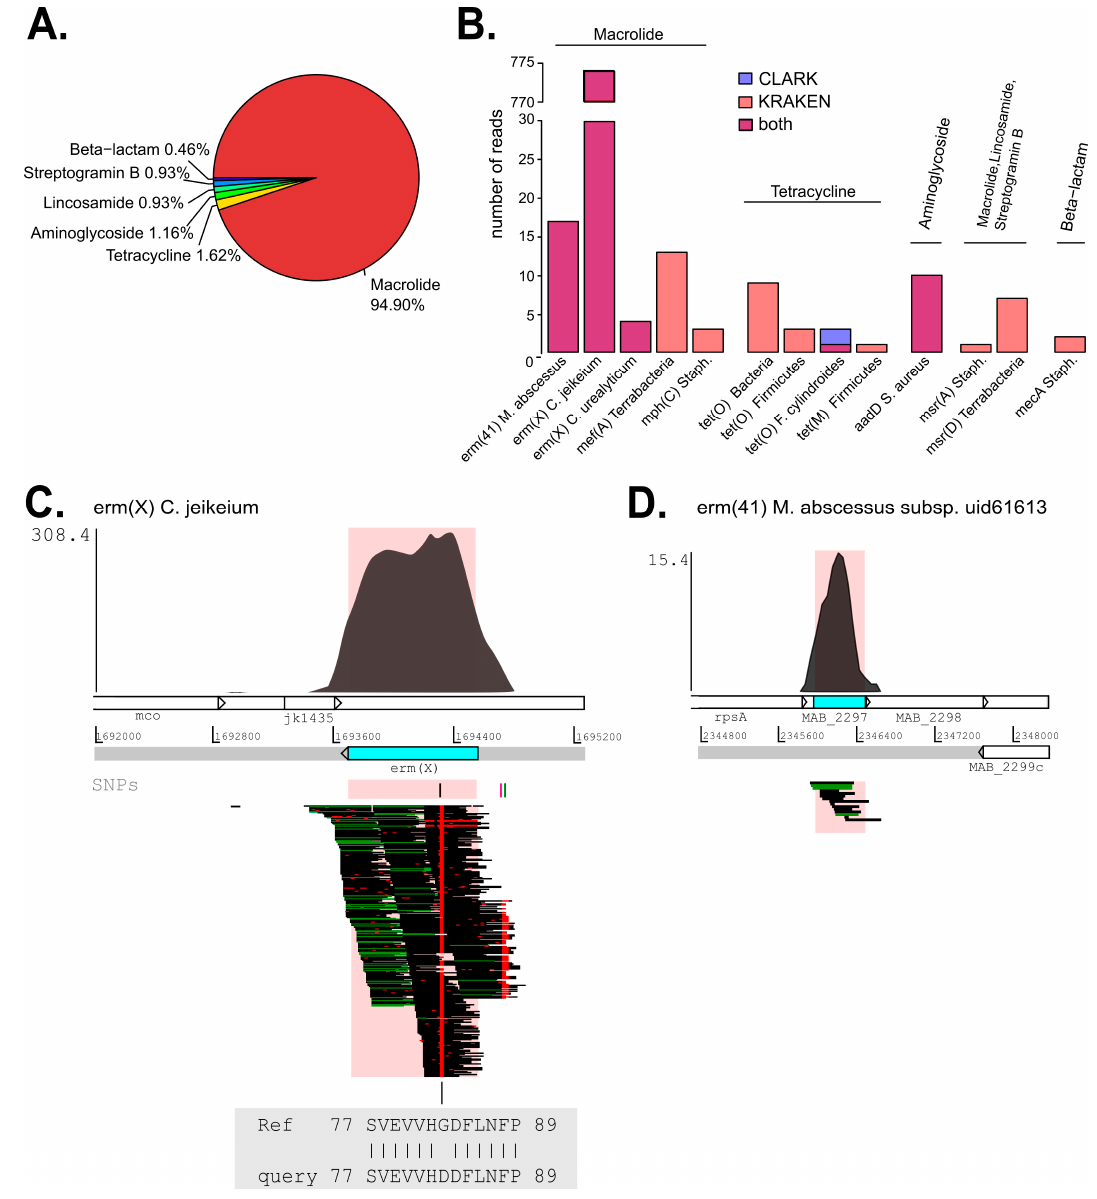
Figure 3. ( A ) Pie chart representing the relative abundance of the antibiotic resistance-determinant (ARD) classes in the metagenome of the enriched BAL sample after quality filtering and merging of sequencing reads. Relative abundance is expressed as percentage of total reads mapped to the ARD ResFinder database (847); ( B ) Barplot reporting the number of reads mapping to the identified ARDs. Colors indicate whether the taxonomic read assignment of an ARD to a given taxon was performed with CLARK (blue violet), with Kraken (coral) or confirmed by both (magenta). Reads that mapped to cfxA and cfxA2 genes remained unclassified; ( C ) Coverage plot of reads mapping to erm (X) locus on the C. jeikeium K411 genome. From top to bottom: density plot of read depth versus genome position; chromosomal position of the erm(X) gene; the open reading frame is colored in sky blue; position of three main single-nucleotide polymorphisms (SNPs) detected; schematic representation of mapped reads grouped in stacks; red dots and lines on stacks represent a nucleotide variant in a given read sequence; amino acid substitution in the ERM(X) protein. The pink-colored area defines the chromosomal landmarks of the gene in the density plot and in the representation of read mapping; ( D ) Coverage plot of reads mapping to the erm (41)-MAB_2297 locus on the M. abscessus ATCC 19977 genome. For further explanation, see panel ( C ). No single nucleotide variants were detected.